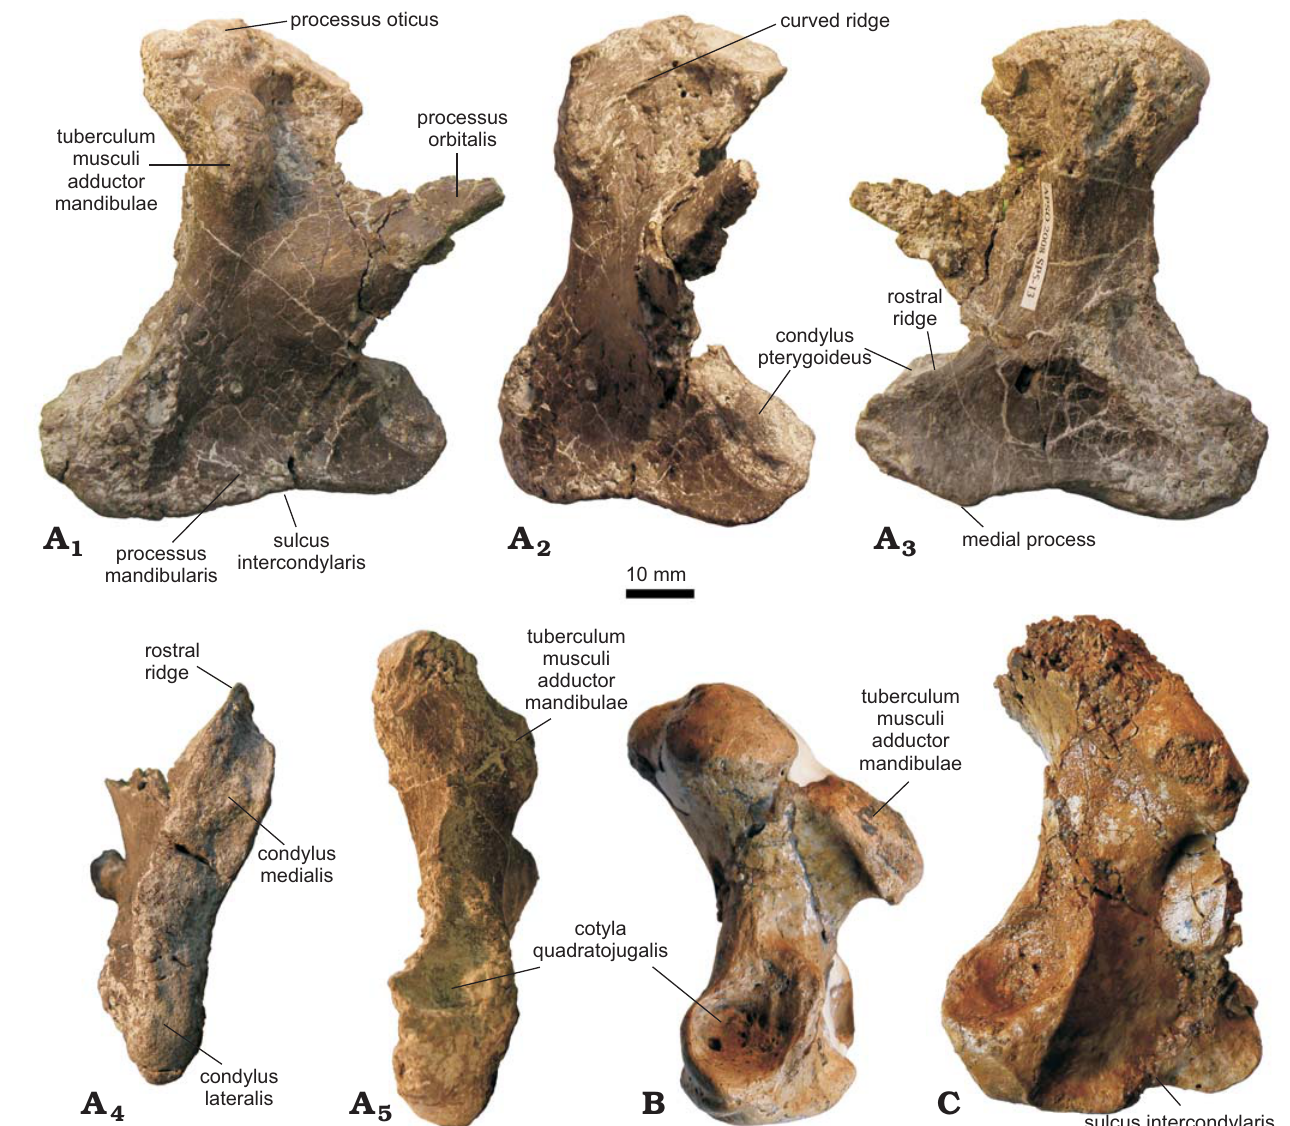
Fig. 2. Quadrata of gastornithid bird Gastornis parisiensis Hébert, 1855. A . MHNT.PAL.2013.15.2 (right), early Eocene, La Borie, France, in lateral (A craniolateral (A ), medial (A ), distal (A ), and caudal (A ) views. B . BR617 (reversed left), late Palaeocene, Berru, France, in laterocaudal view. C . R3561 2 3 4 5 (right), late Palaeocene, Cernay, France, in lateral